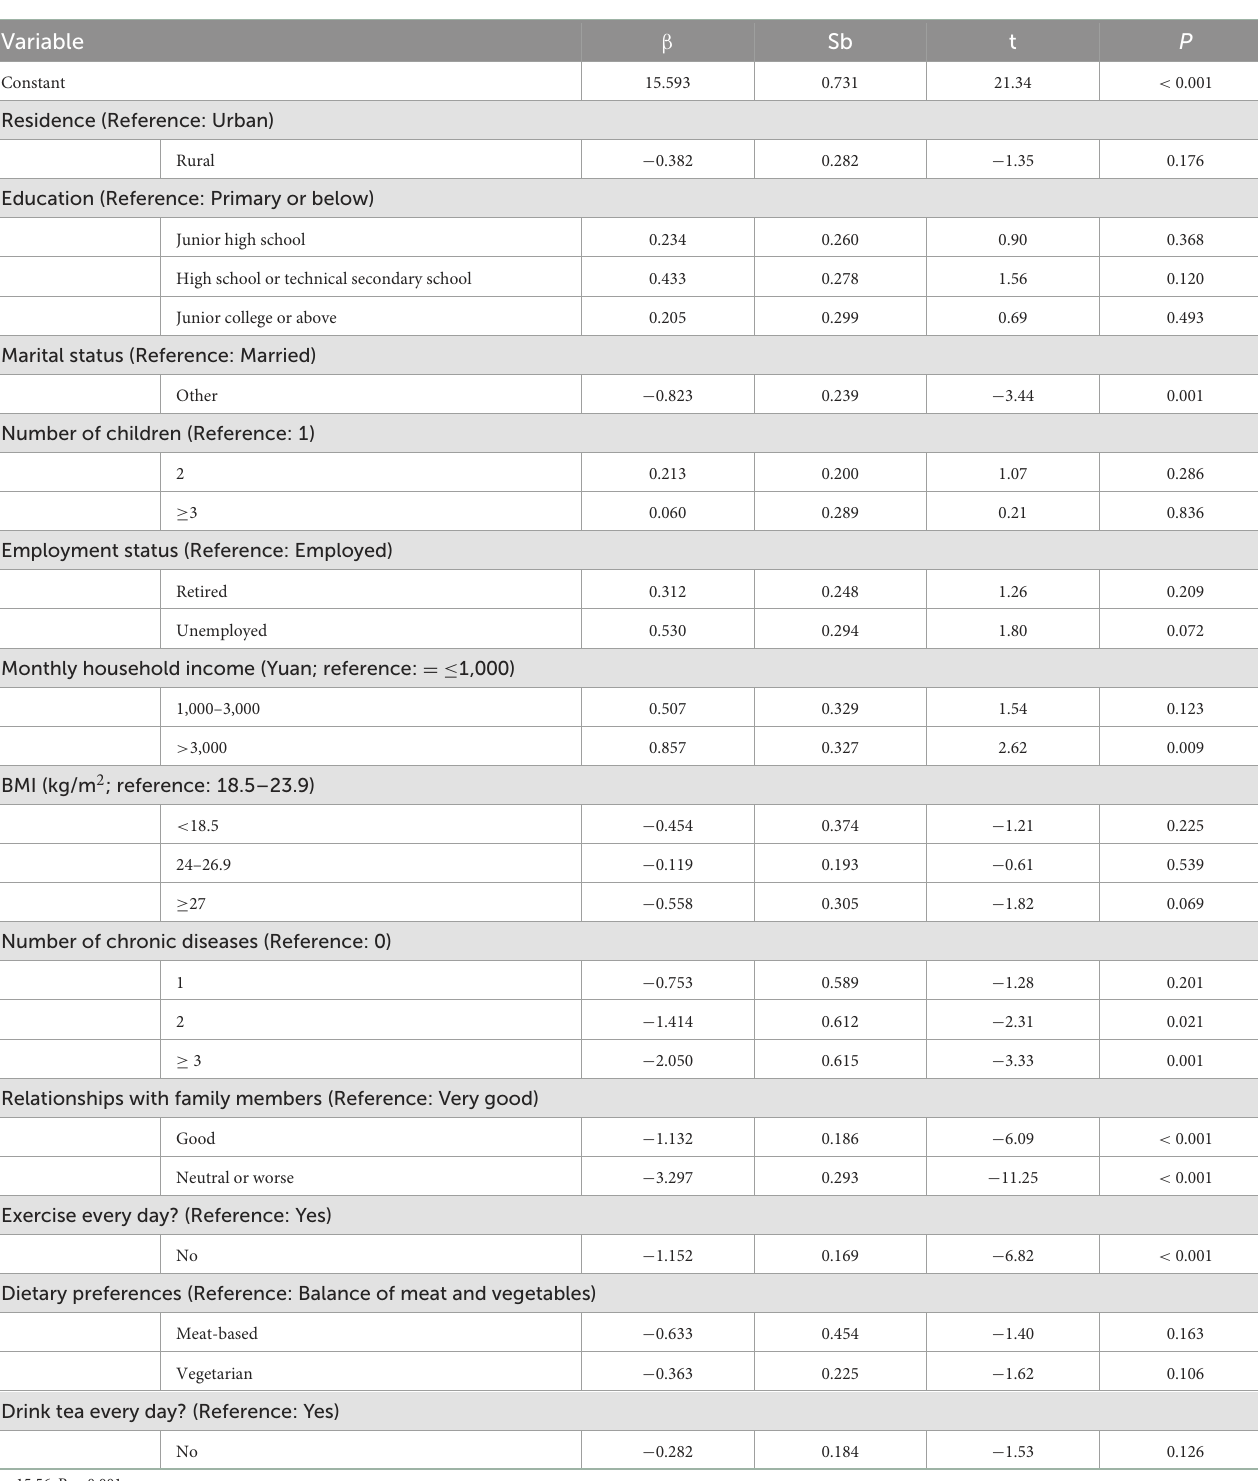
TABLE 4 Multivariate analysis of factors influencing life satisfaction among grandparent caregivers. Variable β Sb t P